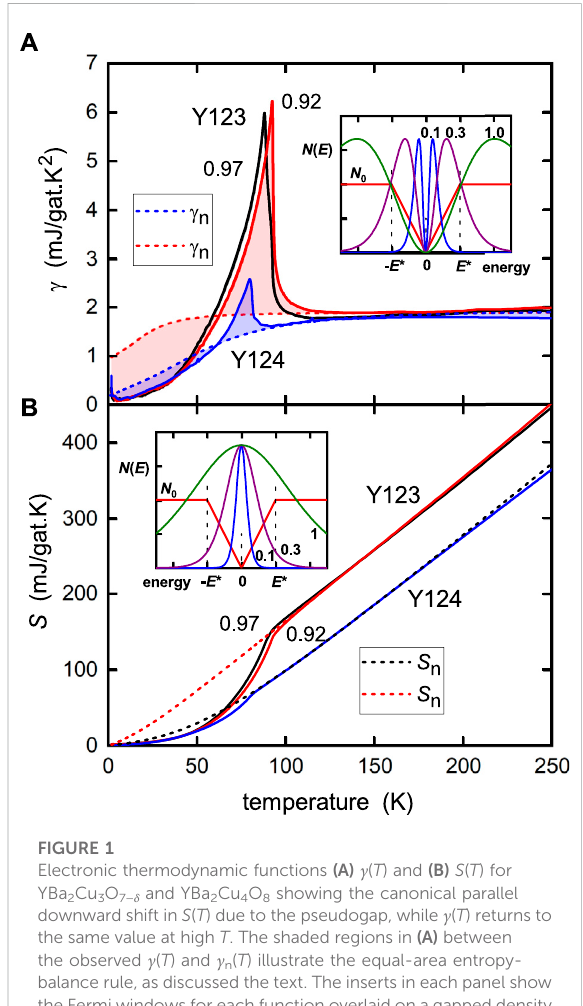
FIGURE 1 Electronic thermodynamic functions (A) γ ( T ) and (B) S ( T ) for YBa 2 Cu 3 O 7 − δ and YBa 2 Cu 4 O 8 showing the canonical parallel downward shift in S ( T ) due to the pseudogap, while γ ( T ) returns to the same value at high T . The shaded regions in (A) between the observed γ ( T ) and γ n ( T ) illustrate the equal-area entropy- balance rule, as discussed the text. The inserts in each panel show the Fermi windows for each function overlaid on a gapped density of states N (E). The blue, purple, and olive-green curves show the Fermi windows for temperatures k B T = 0.1 E *, 0.3 E *, and 1.0 E *, respectively. For S ( T ), the window has a single peak and always sees a gap at E F , so the entropy is always suppressed while the gap remains. In contrast, for γ ( T ), the Fermi window is double peaked about E F and so, at high enough temperature, the window does not see the gap and γ ( T ) returns to its bare